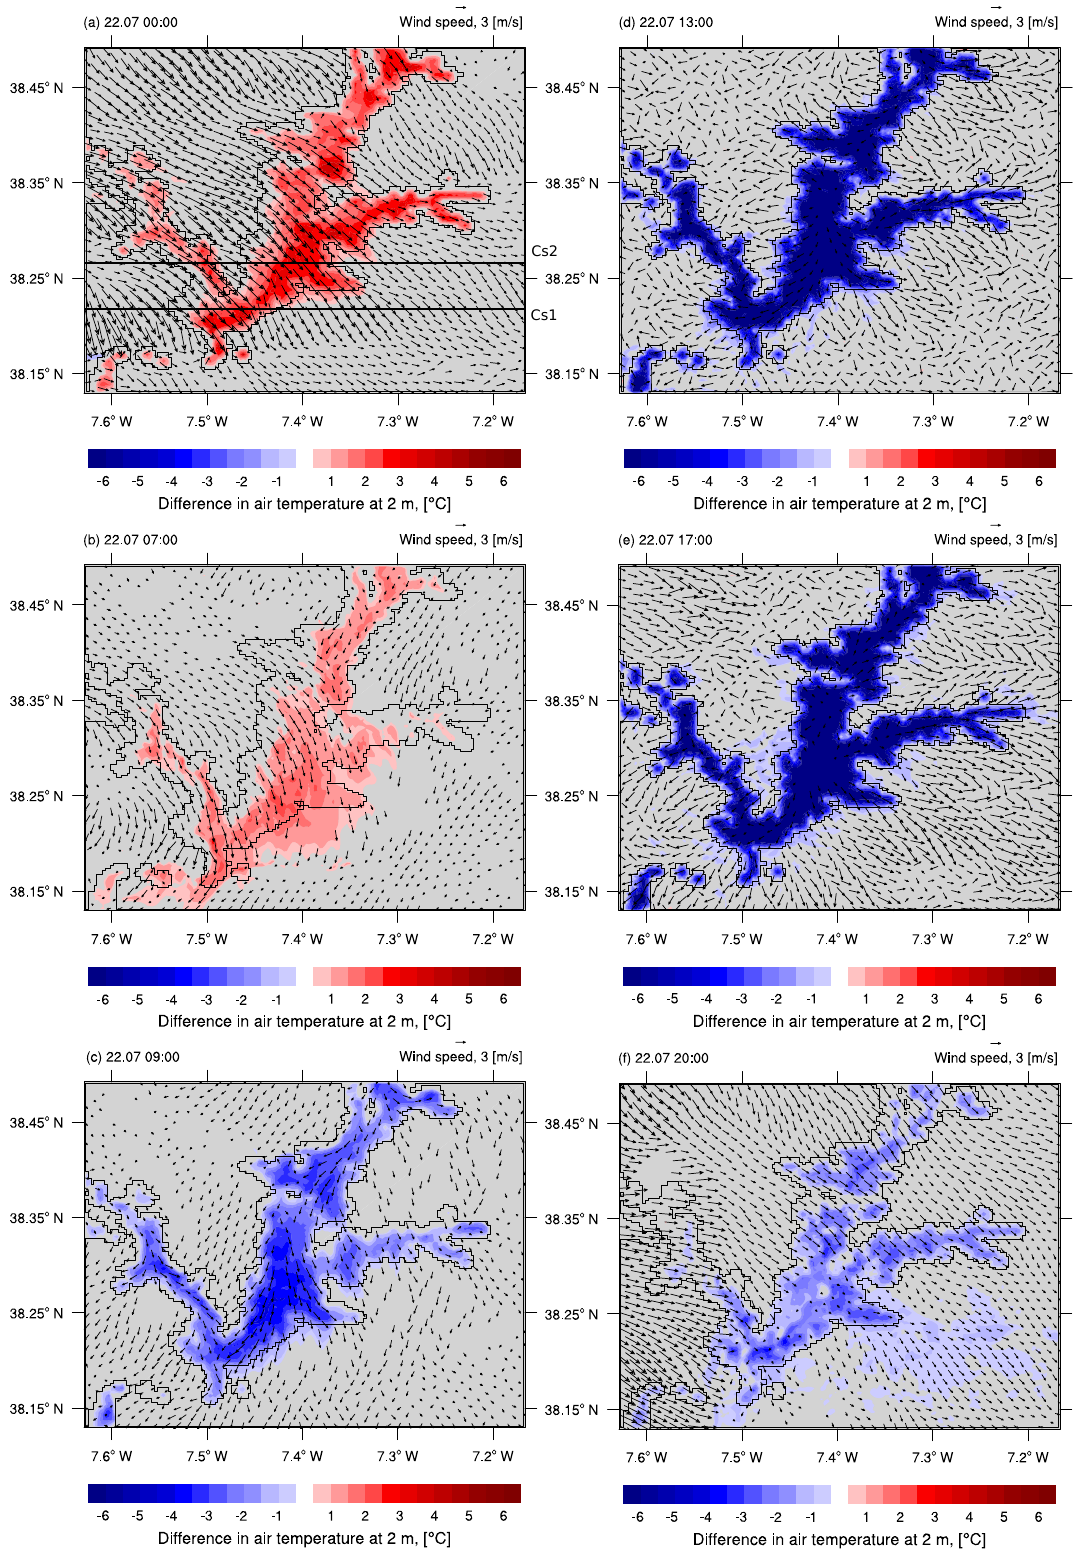
Figure 9. Anomalies in air temperature at 2m (in filled contours) and horizontal wind in LAKE1 experiment (arrays, the scale is indicated in the upper right corner of each figure) of the reservoir on 22 July 2014 in domain C. Horizontal lines in (a) indicate the location of cross sections Cs1 (southern) and Cs2